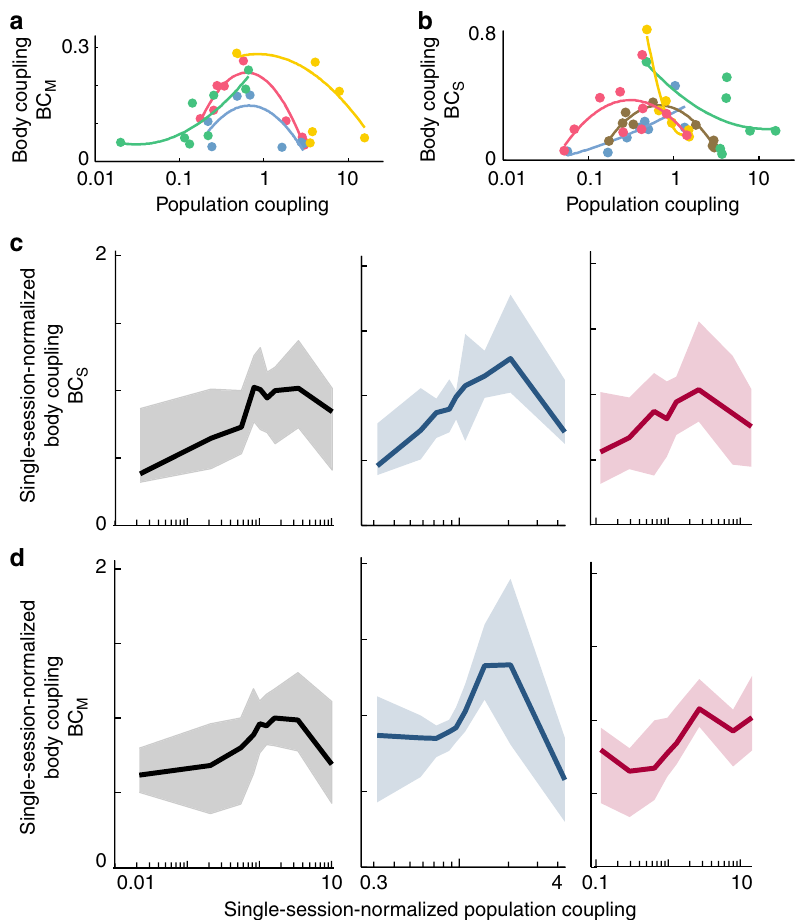
Fig. 6 Results hold within single recording sessions. a Data from four recording sessions are shown (color indicates different sessions). Each point represents one unit. Each line is a quadratic fi t to the corresponding points. Similar to these examples, a signi fi cant number of single sessions were consistent with the peaked relationship between BC M and population coupling found for the pooled results in Fig. 4d. Consistency with the peaked relationship was judged based on the shape of the fi t line (see Methods). b For BC S , a signi fi cant number of single session results were consistent with the pooled results in Fig. 5d. c , d The peaked relationship between body coupling and population coupling persisted after reducing session-to-session variability. Panels c and d represent BC S and BC M , respectively. Each single session was normalized by its median value. Line indicates moving average; shaded region delineates quartiles. Black, blue, and red represent the unaltered, enhanced, and reduced inhibition cases,